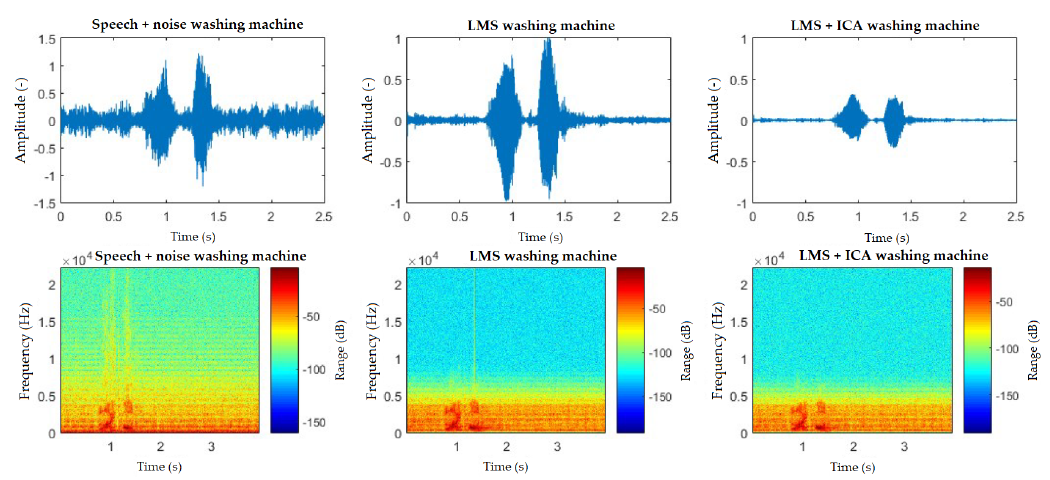
Figure 10. Comparison of spectrograms with closed windows, “light on” command, washing machine interference.